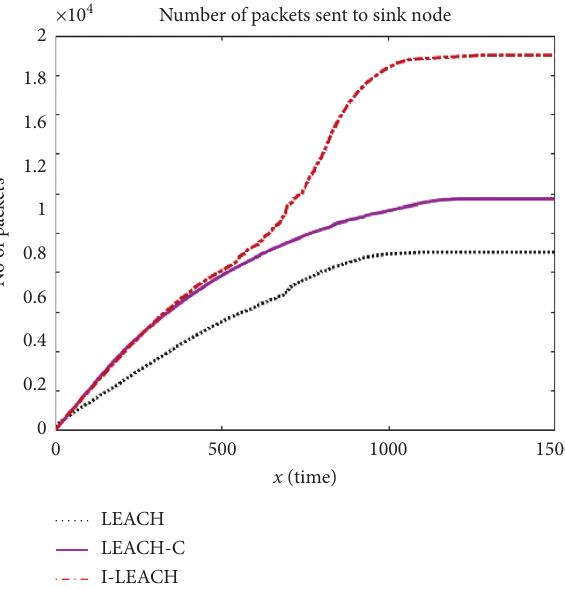
Figure 7: Comparison of the number of dead nodes under the three protocols.